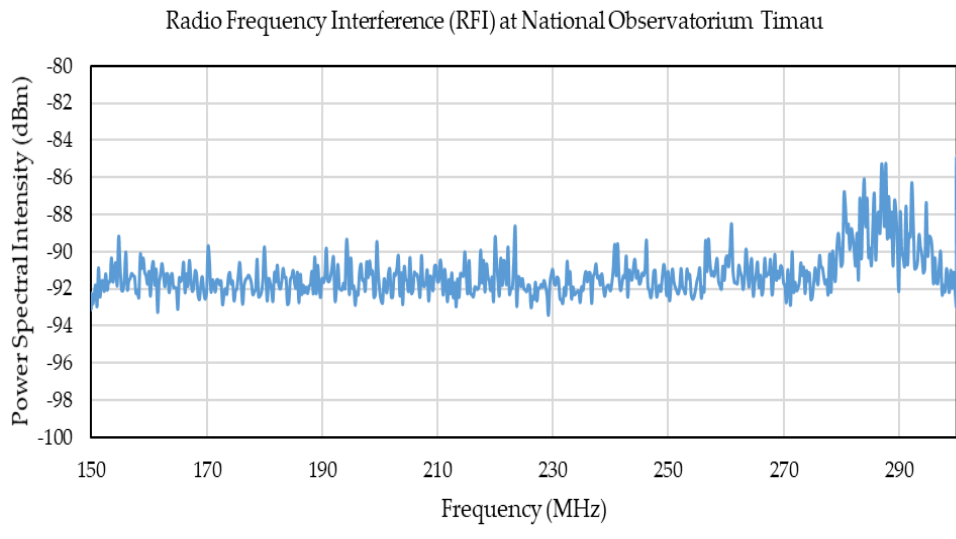
Figure 4. Results of radio frequency survey at low frequencies between 150 and 300 MHz.